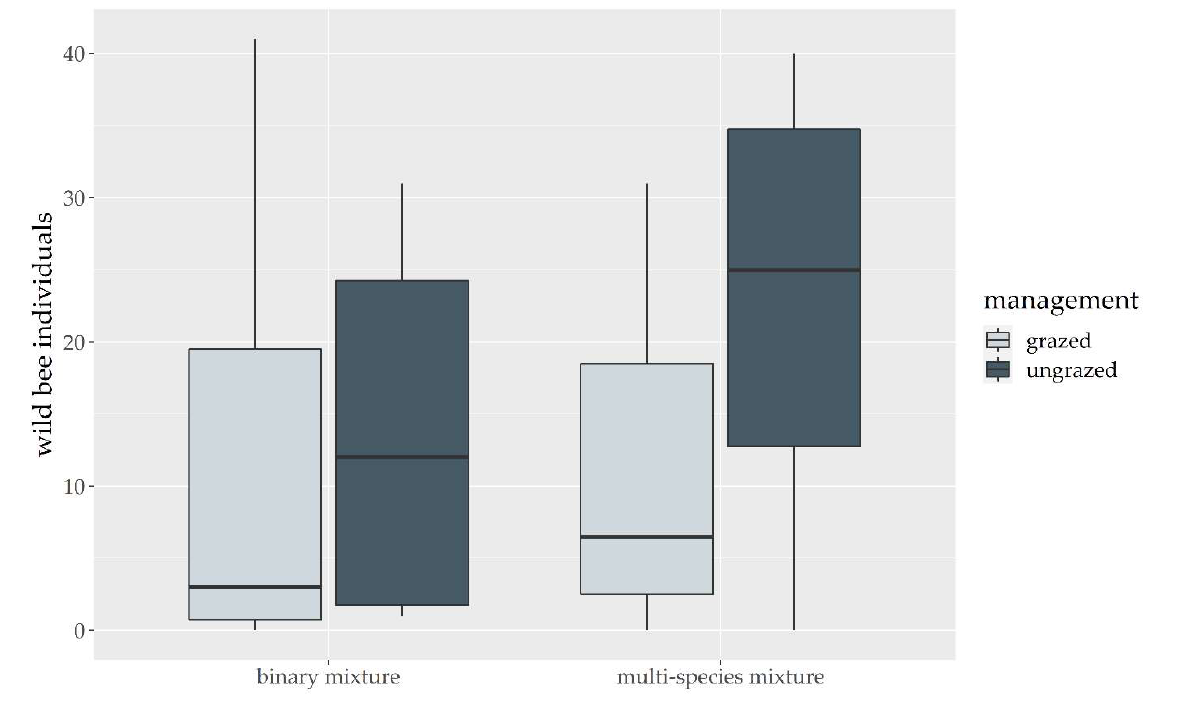
Figure 3. Numbers of wild bee individuals on grazed pastures and ungrazed strips (management) of the binary mixture and multispecies mixture.